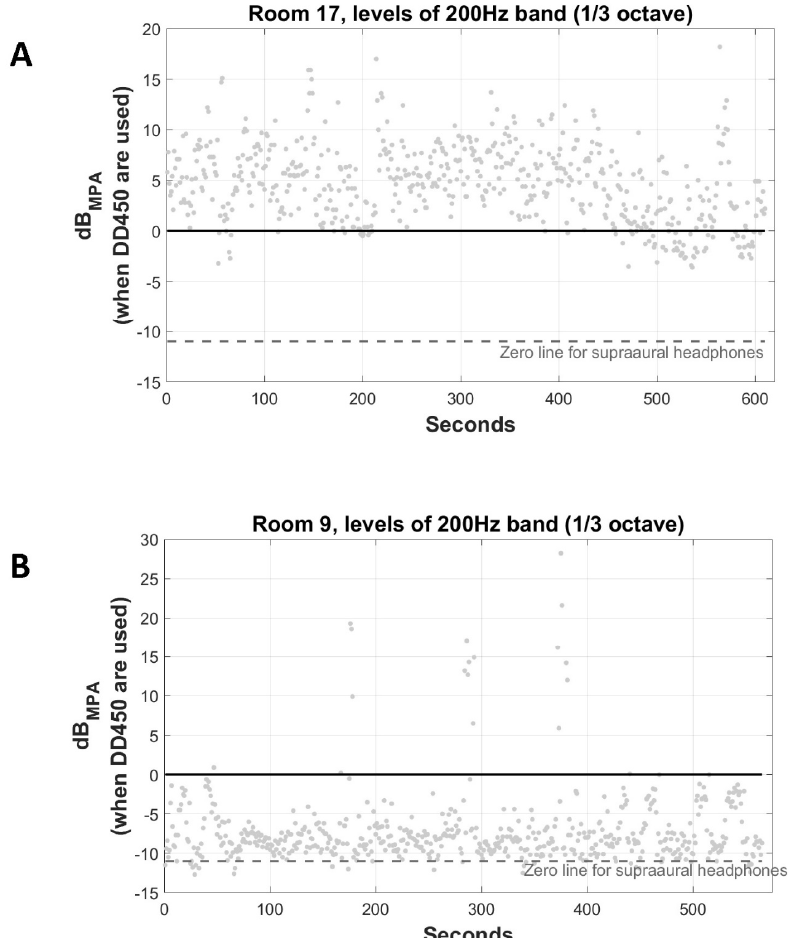
Figure 2. ( A ) Ambient noise of 200 Hz band in a room with quasi-constant violations. ( B ) Ambient noise of 200 Hz band in a room without quasi-constant violations. dB MPA refers to levels with respect to Maximum Permissible Ambient noise levels when DD450 circumaural headphones are used. Dashed grey line refers to Maximum Permissible Ambient noise levels when typical supra-aural headphones are